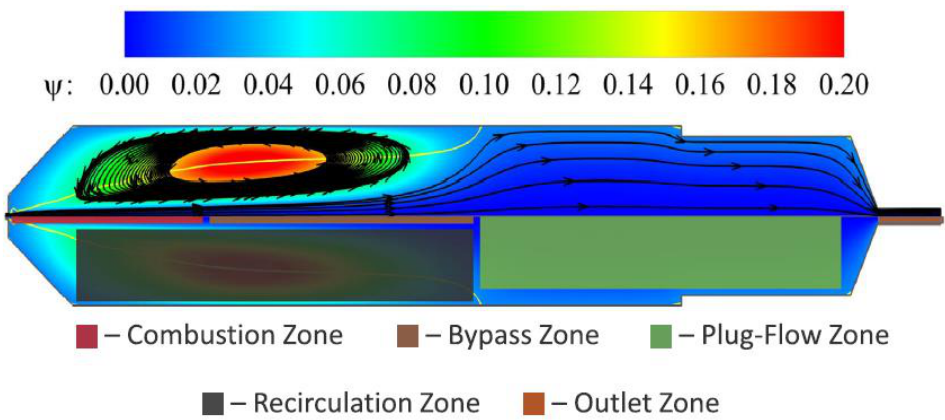
Figure 2. Flow function in a typical Virtuhcon Benchmark reactor derived from 2D axisymmetric CFD simulation [60]: the upper part of the figure reflects the flow function ψ and the flow direction; the yellow curve in the middle part indicates the limit of zero axial velocity; the lower part reflects the different zones of the conversion.